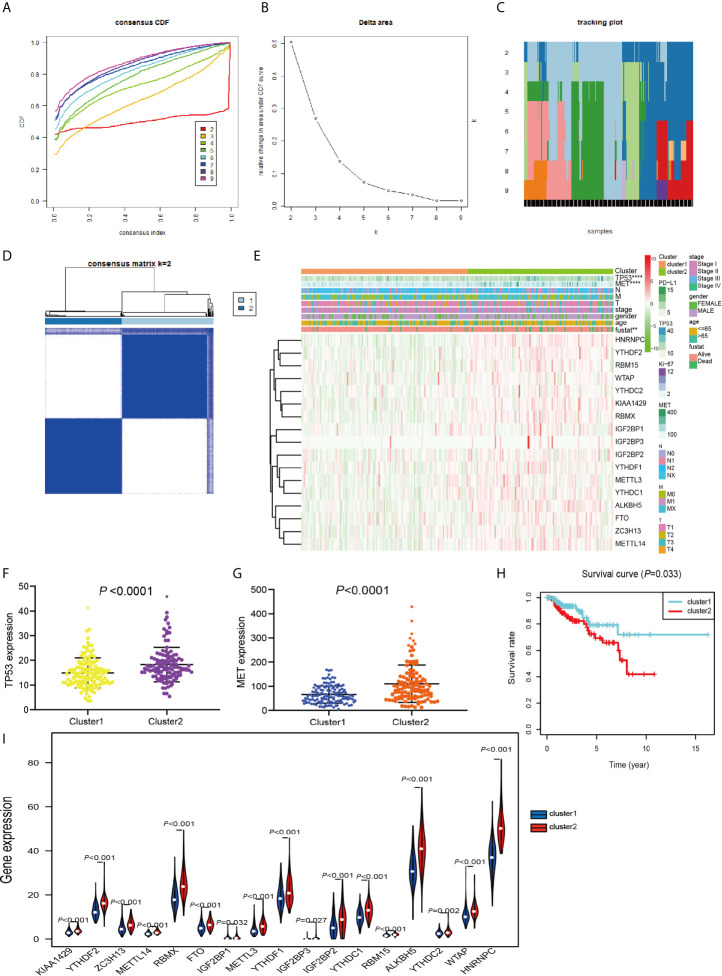
Differential clinicopathological features and OS of PRCC in the cluster 1/2 subgroups. (A) Consensus clustering cumulative distribution function (CDF) for k = 2 to 9. (B) Relative change in area under the CDF curve for k = 2 to 9. (C) The tracking plot for k = 2 to 9. (D) Consensus clustering matrix for PRCC. (E) Heatmap and clinicopathologic features of the two subgroups classified by the m6A RNA methylation regulatory gene consensus expression in PRCC. (F) Comparison of TP53 expressions in different subgroups. (G) Comparison of MET expressions in different subgroups. (H) Kaplan-Meier curves analysis for PRCC patients in cluster 1 and 2. (I) Violin plots displayed the distribution of m6A RNA Methylation Regulators expression in cluster 1 and cluster 2. **P < 0.01, ****P < 0.0001.